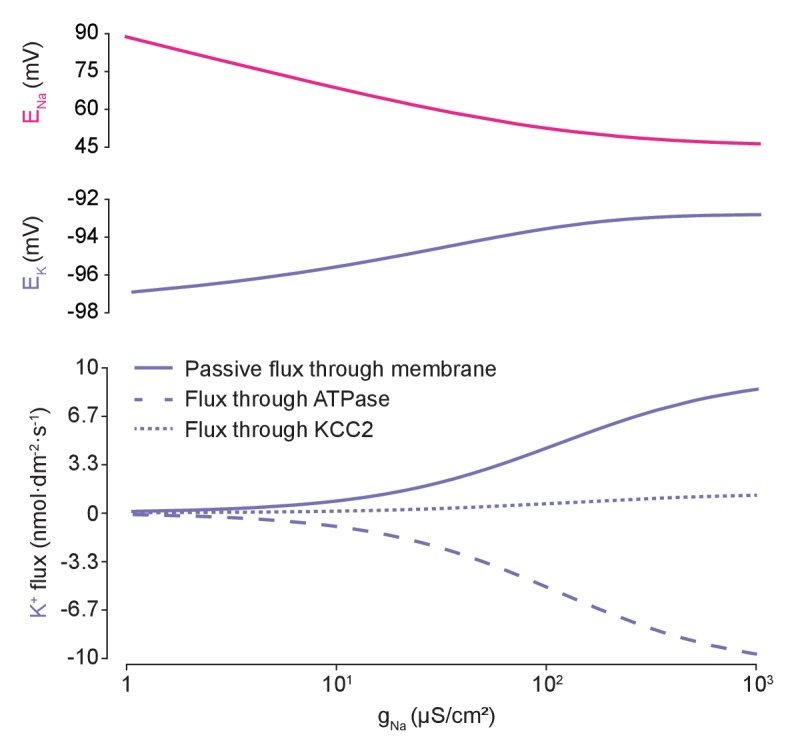
K+flux is balanced by active and passive fluxes, dependent on Na+steady states.Varying gNa in the analytical solution caused a reduction in ENa (top panel, pink) and non-zero increases in EK (middle panel, purple). The EK changes with increasing gNa are small because the increased K+ efflux through passive leak membrane channels accompanying membrane depolarisation (bottom panel, solid line) are compensated by increased ATPase K+ influx driven by the Na+ concentration changes (dashed line). KCC2 plays a smaller role (dotted line).